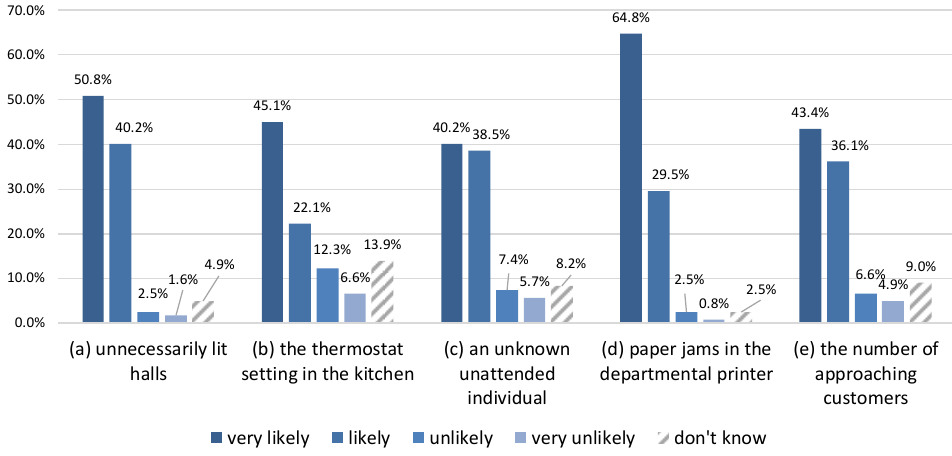
Figure 5. The willingness to answer the five sensing requests included in the questionnaire.